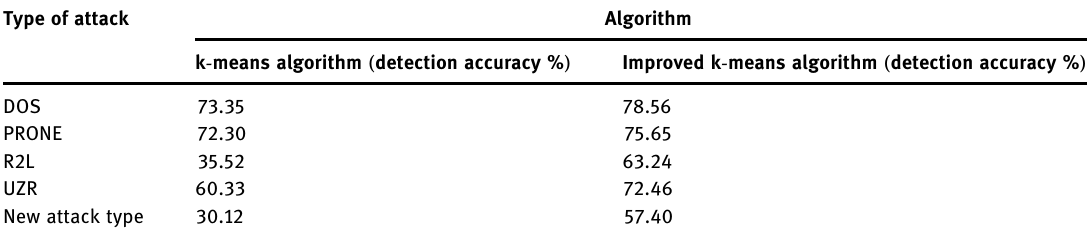
Table 10: Detection e ffi ciency of the two algorithms Type of attack